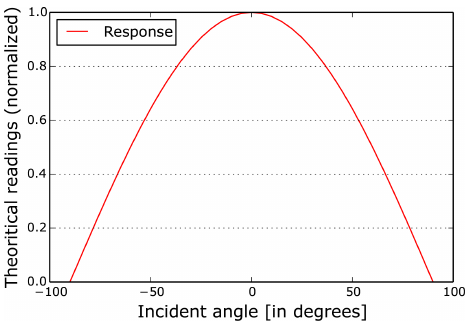
Figure 4. Response of the solar sensor on a clear day with a varying solar incident